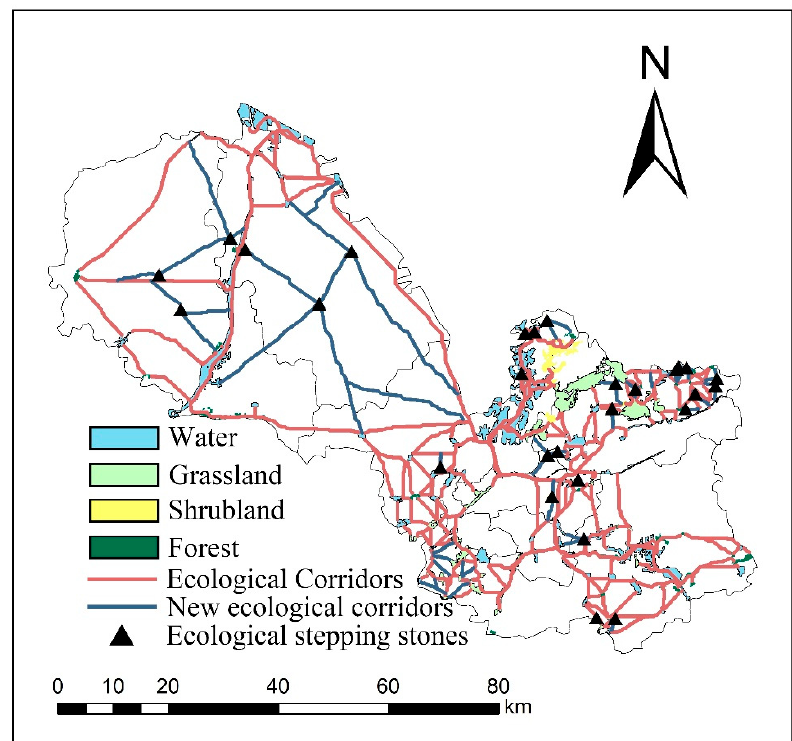
Figure 10. Optimized ecological space